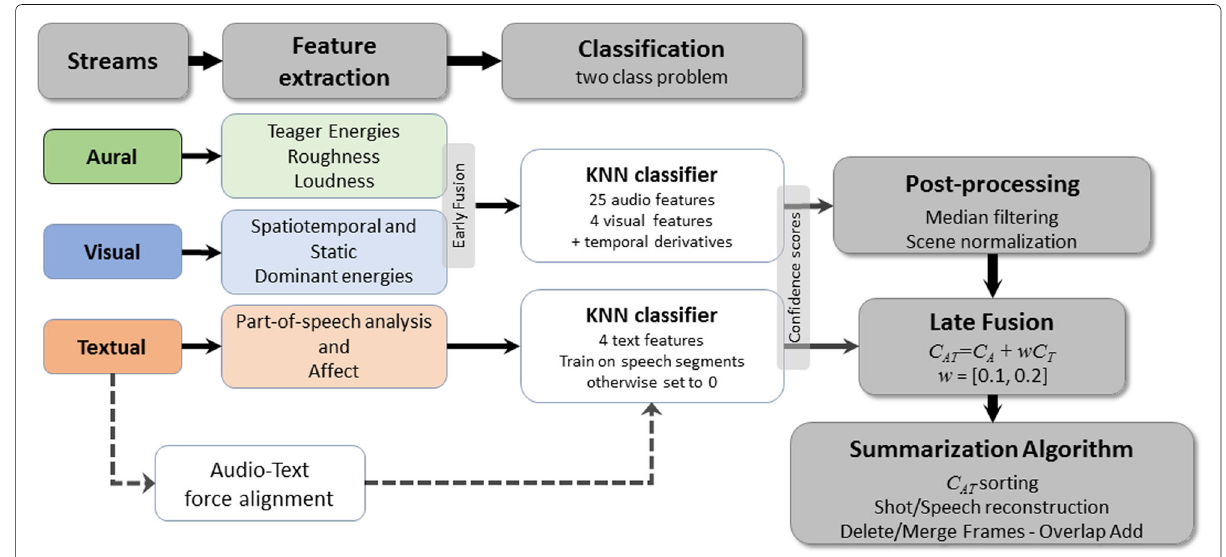
Fig. 9 System overview for multimodal saliency and summarization